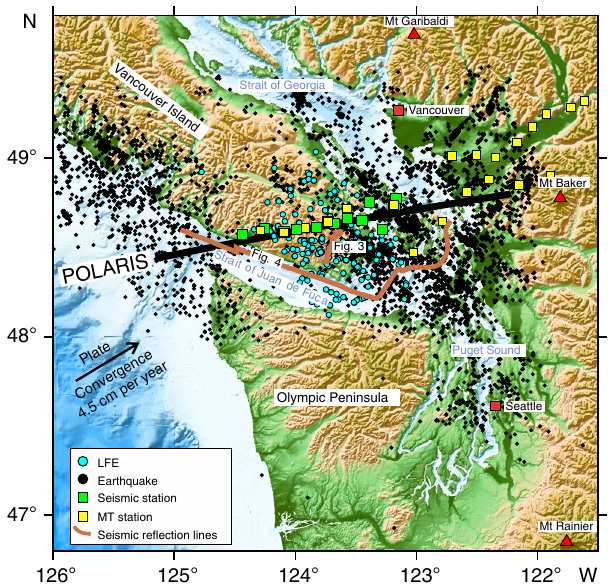
Fig. 1 Location of geophysical studies in northern Cascadia subduction zone. Solid black line shows the POLARIS (Portable Observatories for Lithospheric Analysis and Research Investigating Seismicity) pro fi le along which the different sections in Fig. 2 were obtained from the tomographic velocity models. Solid brown lines are the short onshore and longer offshore seismic re fl ection sections shown in Figs. 3 and 4 respectively. The earthquakes and low-frequency earthquakes (LFE) used in the tomography study are shown by fi lled black and fi lled blue circles respectively. Green squares — seismic stations used to infer landward dipping zone of very high Poisson ’ s ratio and ultra-low S wave velocity (ULVZ), yellow squares — magnetotelluric (MT) stations used to create resistivity section in Fig.